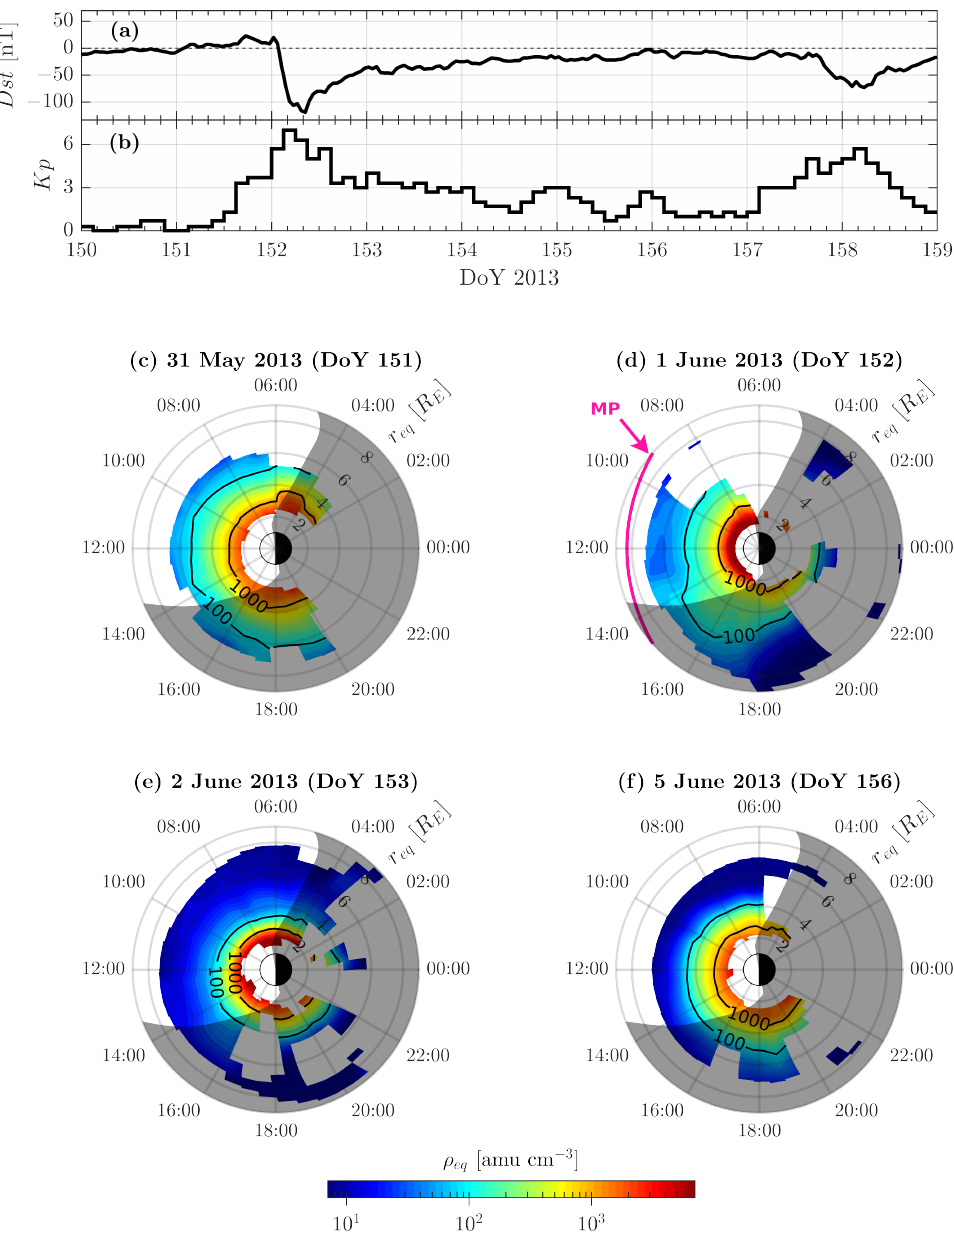
Figure 4. Panels ( a , b ) show variations of the Dst and Kp indices, respectively; the four polar plots are a sequence of plasma density maps, as obtained from EMMA measurements; the Sun is to the left; shaded sectors refer to plasma density inferred for field lines having at least one footprint not lighted by the Sun; ( c ) saturated plasmasphere; ( d ) principal phase of the storm; a drainage plume formation is clearly visible; ( e ) eroded plasmasphere early in the recovery phase; ( f ) plasmasphere partially refilled in the late recovery phase; the magenta line is the magnetopause position from the Shue et al. [80] model; it is visible only during the main phase, when the magnetosphere shrinks below 9 R E